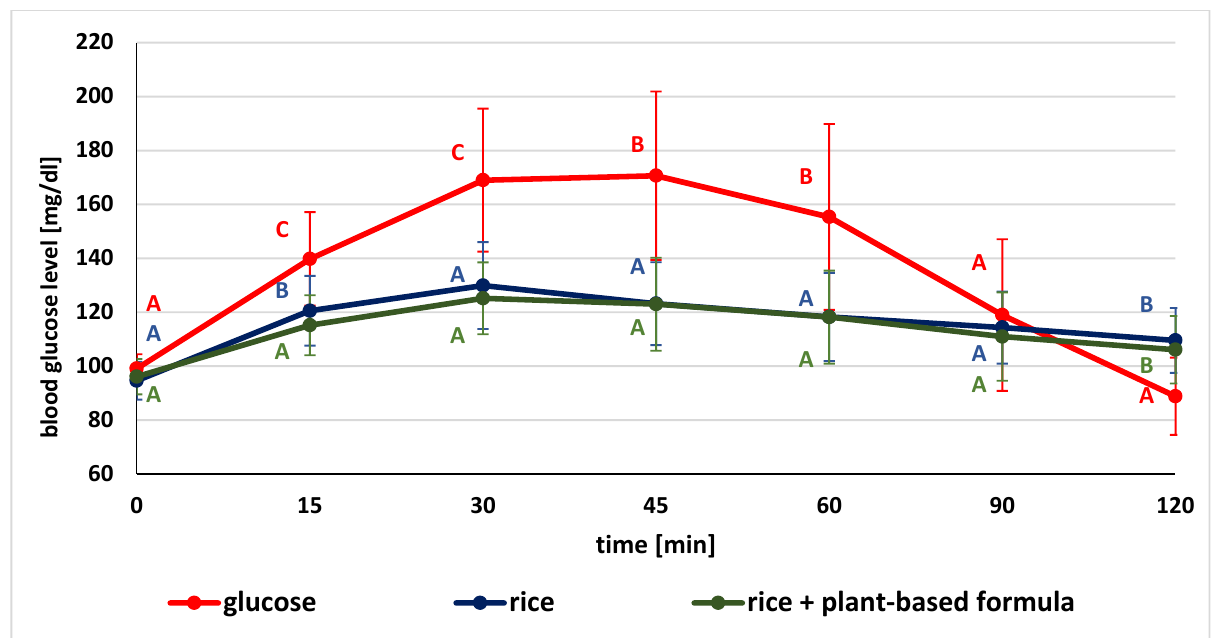
Figure 3. Comparison of mean blood glucose level after consumption of standard glucose solution and white rice without and with plant-based formula (for variables with the same letter, the difference is not statistically significant; error bars represent standard deviation, p > 0.05; one-way repeated-measures ANOVA).